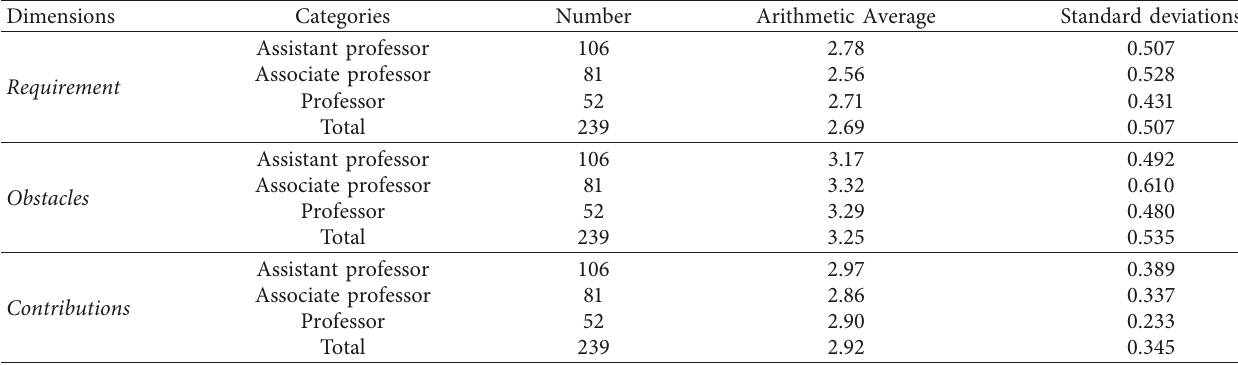
Table 10: Arithmetic averages and standard deviations of scientific rank’s impact on distant education requirements, impediments, and potential remedies in the face of university educational crises.